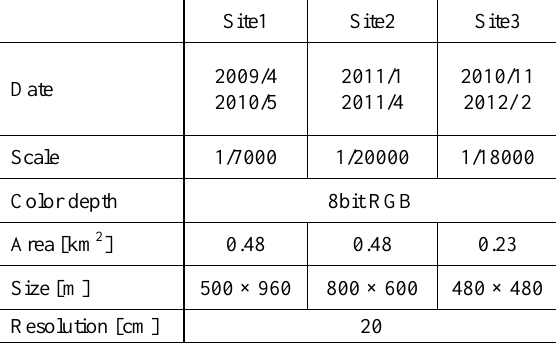
Fig.3. Photomaps and changed buildings (red circle) Table 1. Photomap